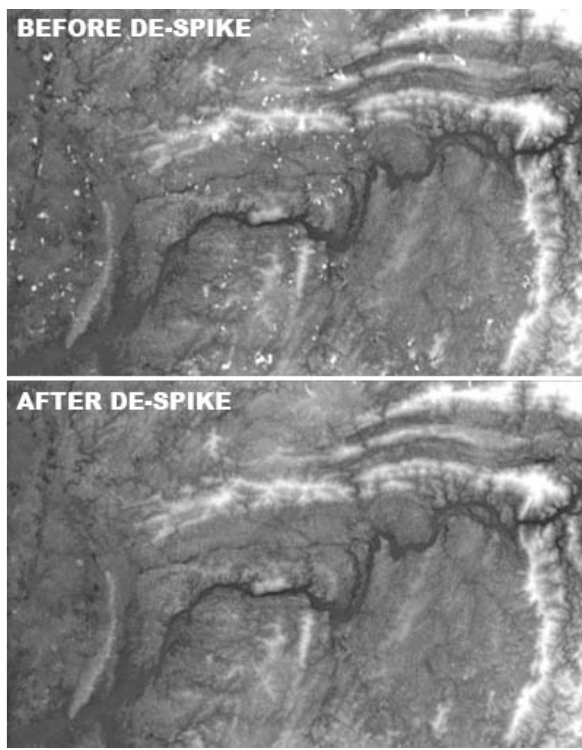
Figure 4. SRTM Water Body Database errors corrected to water (red) and to land (cyan) via the GDEM water mask. Sulu Archipelago, Philippines, N05E120. Black = water.